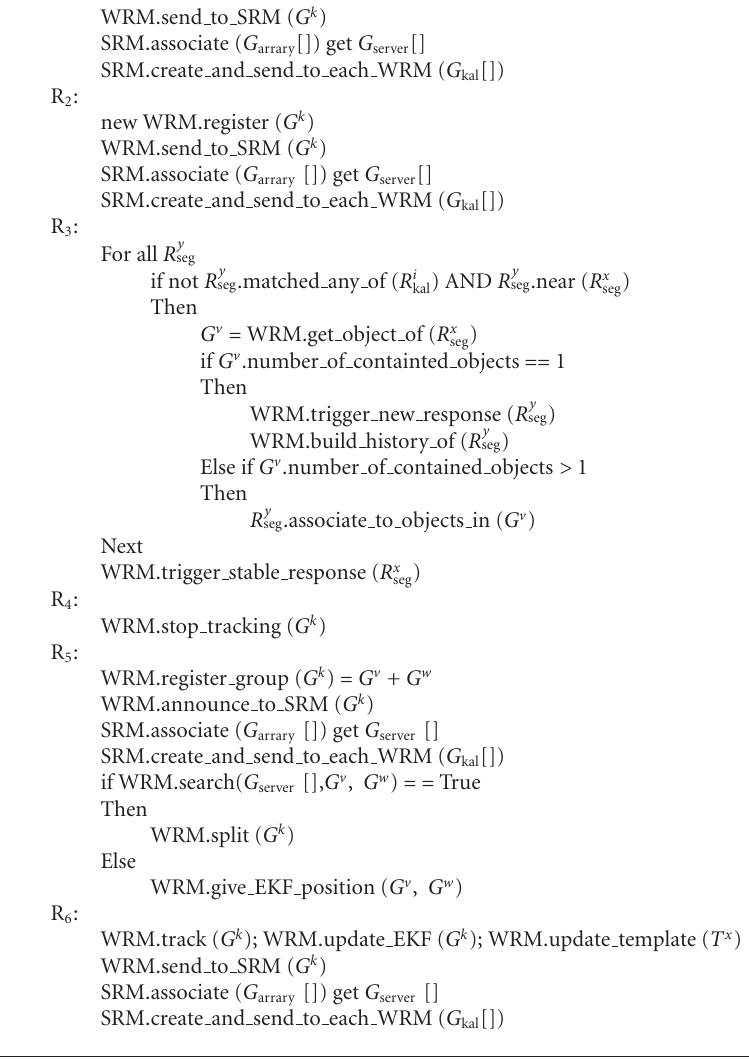
Algorithm 4: The tracking events